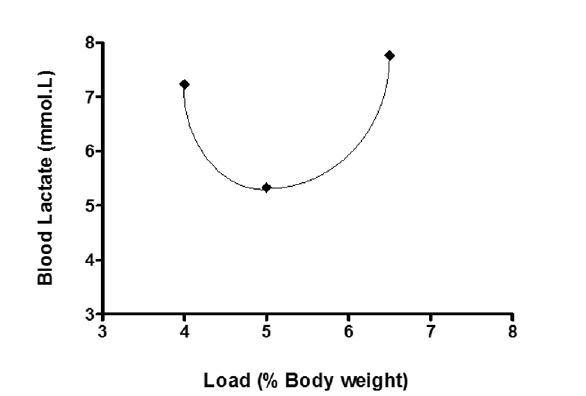
Figure 4. Blood lactate concentration curve versus workload of one rat (S group) during the post-training LACmin 1.408 x 2 – 14.572 x + 42.99 enabled the calculation of the BLM con- centration and its workload (%